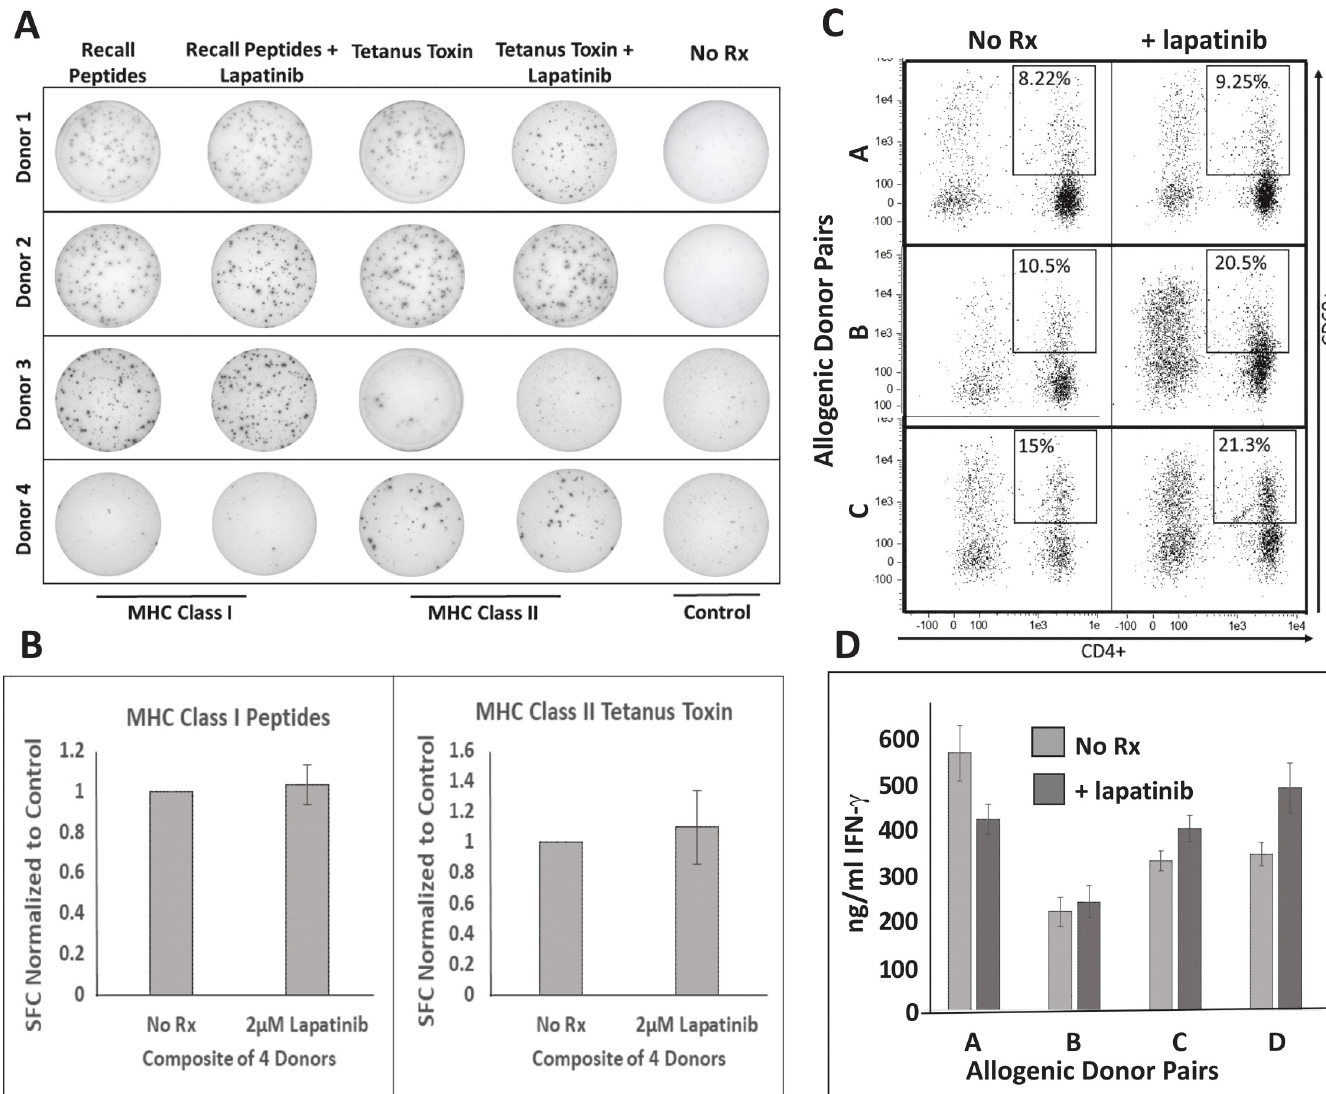
Fig 8. Lapatinib does not suppress T lymphocyte activation or function. A) IFN- γ ELISPOT assayof unfractionated human PBMCs from four unique donors stimulated with MHC class I recall peptides or tetanus toxoid protein in the presence of 2 μ M lapatinib. B) Composite data of the number of IFN- ɣ spot forming cells (normalized to control)from the same four donors. C) Flow cytometry analysis of allogenic DC:T cell co-cultures from three unique allogeneic stimulator:responder pairs with staining for CD4 (x axes) and CD69 (y axes). Percentage values indicate proportion of double-positive cells. D)ELISA analysis of IFN- ɣ production from four unique allogeneic stimulator:responder pairs in the presence or absence of